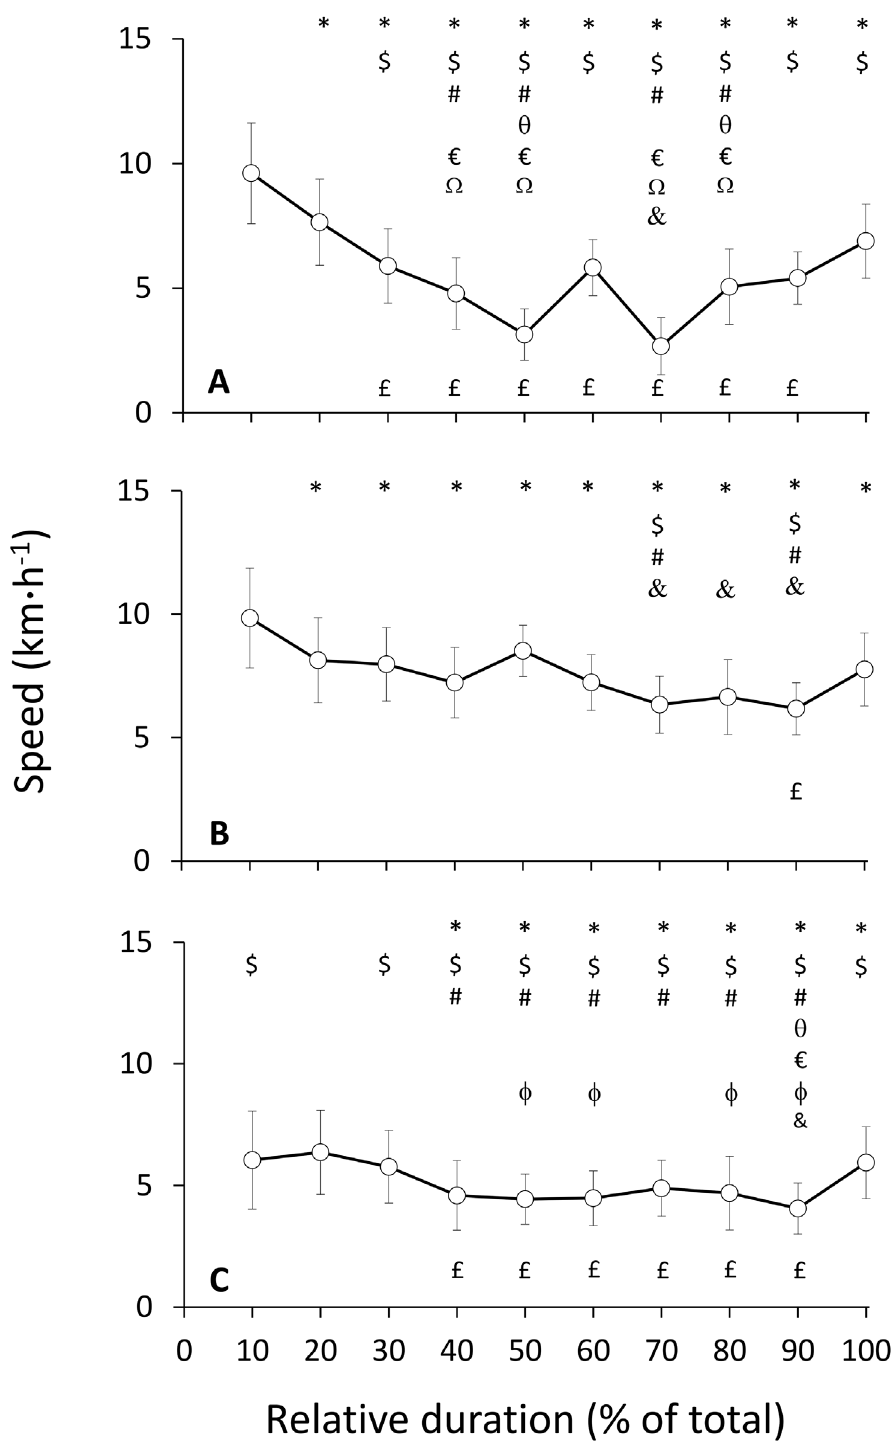
Fig 3. Dynamics of speed. Mean ( ± SD) group speed as a function of event duration in (A) level, (B) negative (C) and positive gradients, respectively. Symbols denote significant differences to ( * ) 10%, ($) 20%, (#) 30%, ( θ ) 40%, (&) 50%, ( € ) 60%, ( ϕ ) 70%, ( Ω ) 90% and (£) 100% of total event duration, at p <